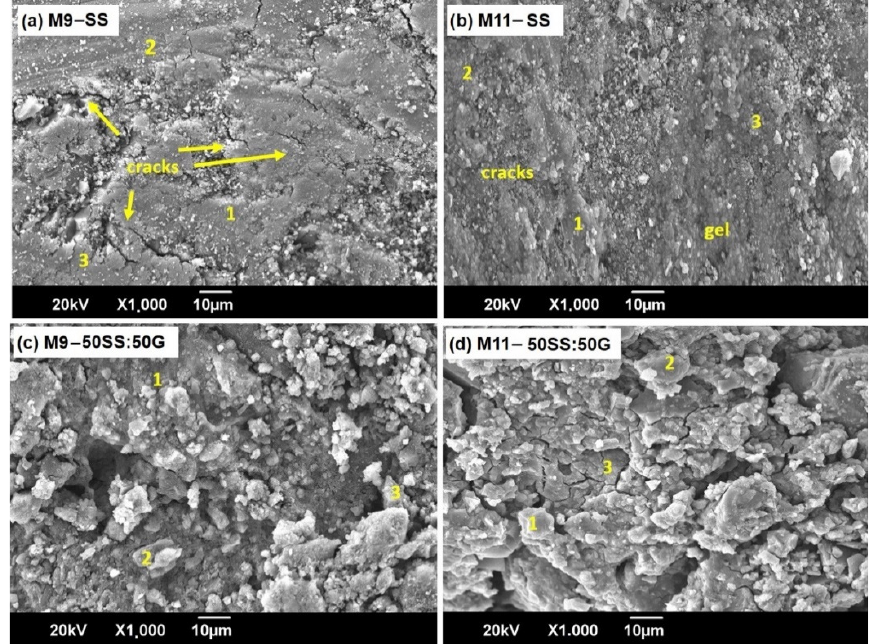
Figure 5. SEM images for pastes: ( a ) M9-100SS, ( b ) M11-100SS, ( c ) M9-50SS:50G, ( d ) M11-50SS:50G.